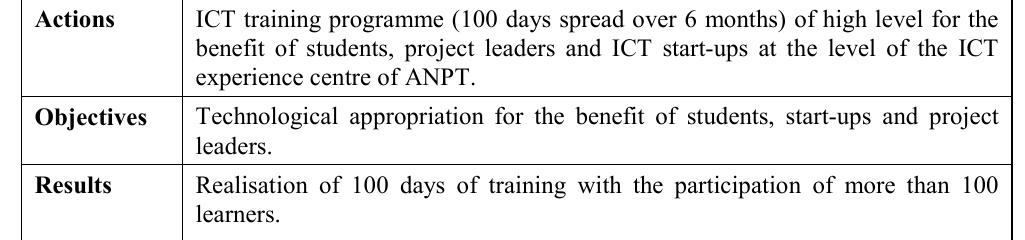
Table 3. Objectives, Actions and Results of the Year 2017